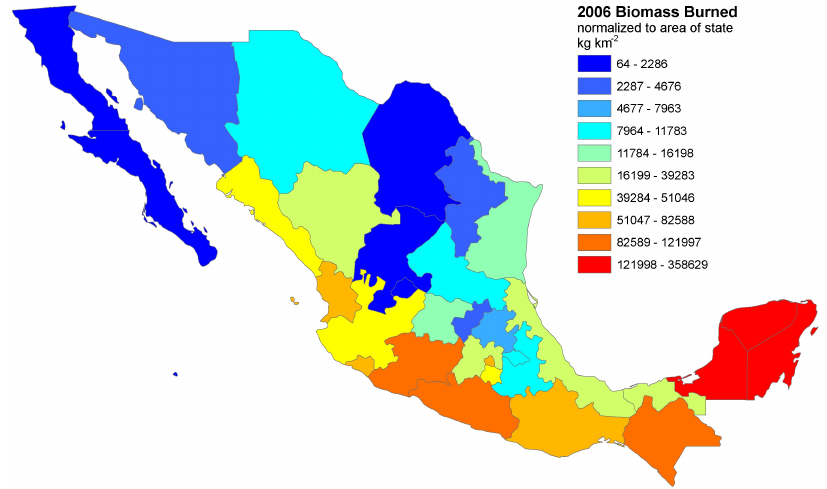
Fig. 8. Map showing the amount of biomass burned in each Mexican state (as calculated by the FINNv1 model) normalized by the area of the state. The warm colors indicate an arc of high intensity biomass burning south of the Mexico City metropolitan area and stretching about 2000km from coast to